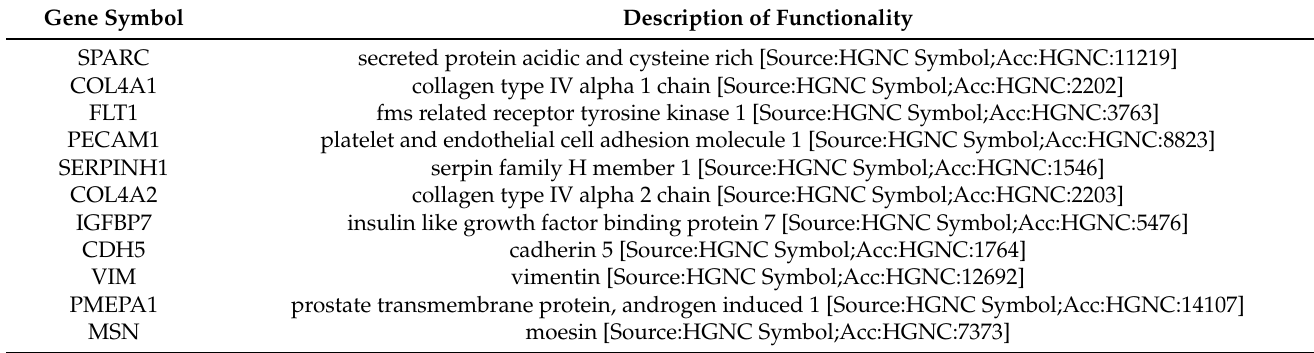
Table A4. List of 15 out of 20 overlapped genes between our top 20 ranked genes and pancreas gene sets